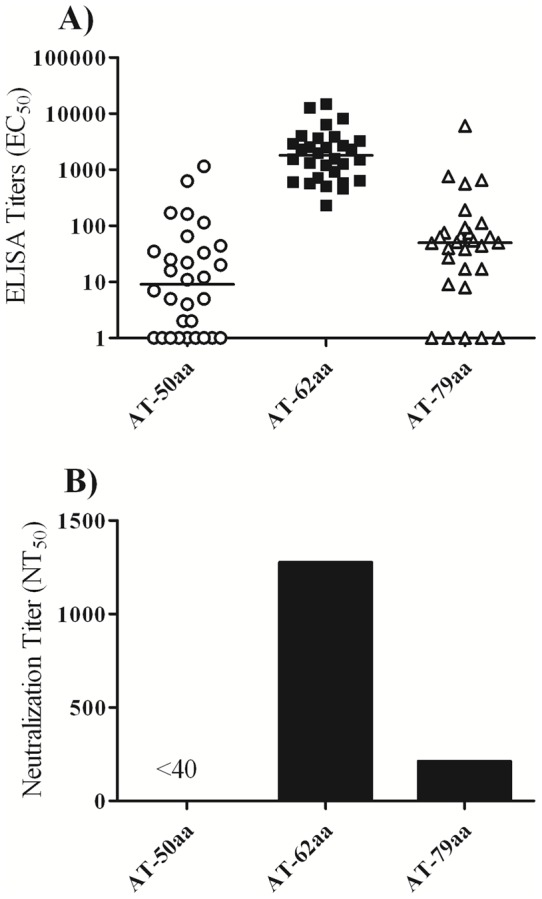
Comparative antibody response to vaccine candidates.(A) Individual serum antibody titers towards wild-type Hla determined after three immunizations (B) Neutralization titers of pooled sera towards wild-type Hla after three immunizations.